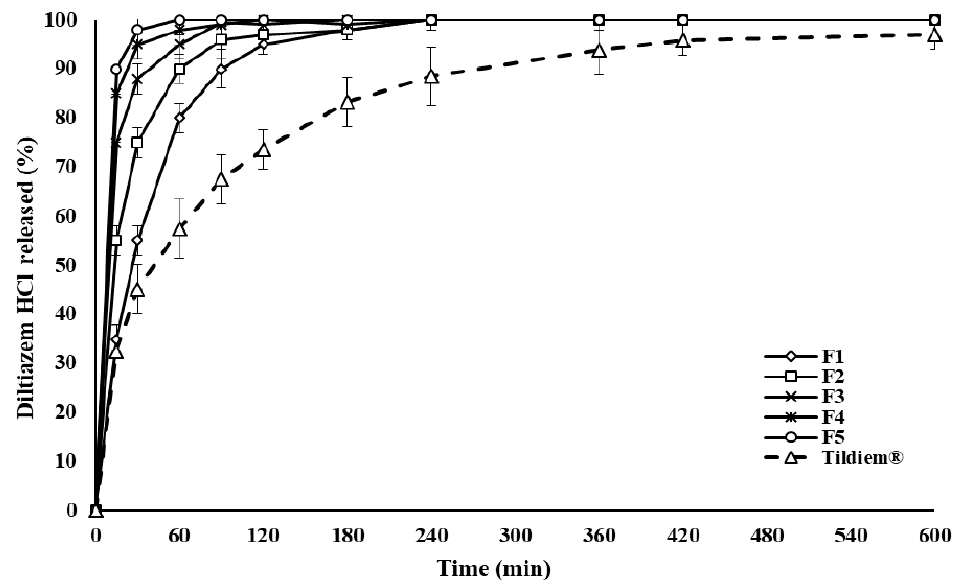
Figure 2. The rate of DLZ-controlled release from polymer matrices of various drug to polymer percentages and Tildiem ® over 600 min, using distilled water at 37 ◦ C, values are means ± S.D. ( n = 6). Table 1. Controlled release polymer matrices containing various drug to polymer percentages.